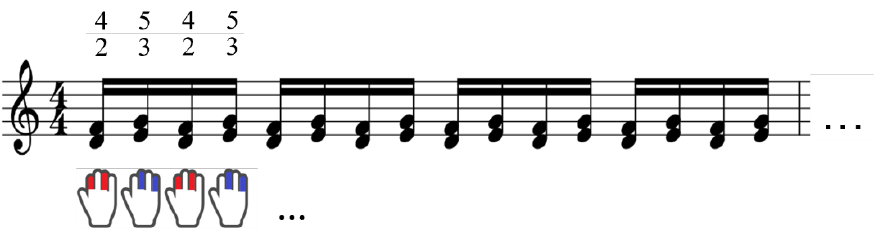
Figure 2. The experimental task. The experimental task required the repetition of two sets of simultaneous keystrokes of the two keys, leaving one white key in between (i.e., a major third interval), using the right index and ring fingers for one set and the right middle and little fingers for the other set.